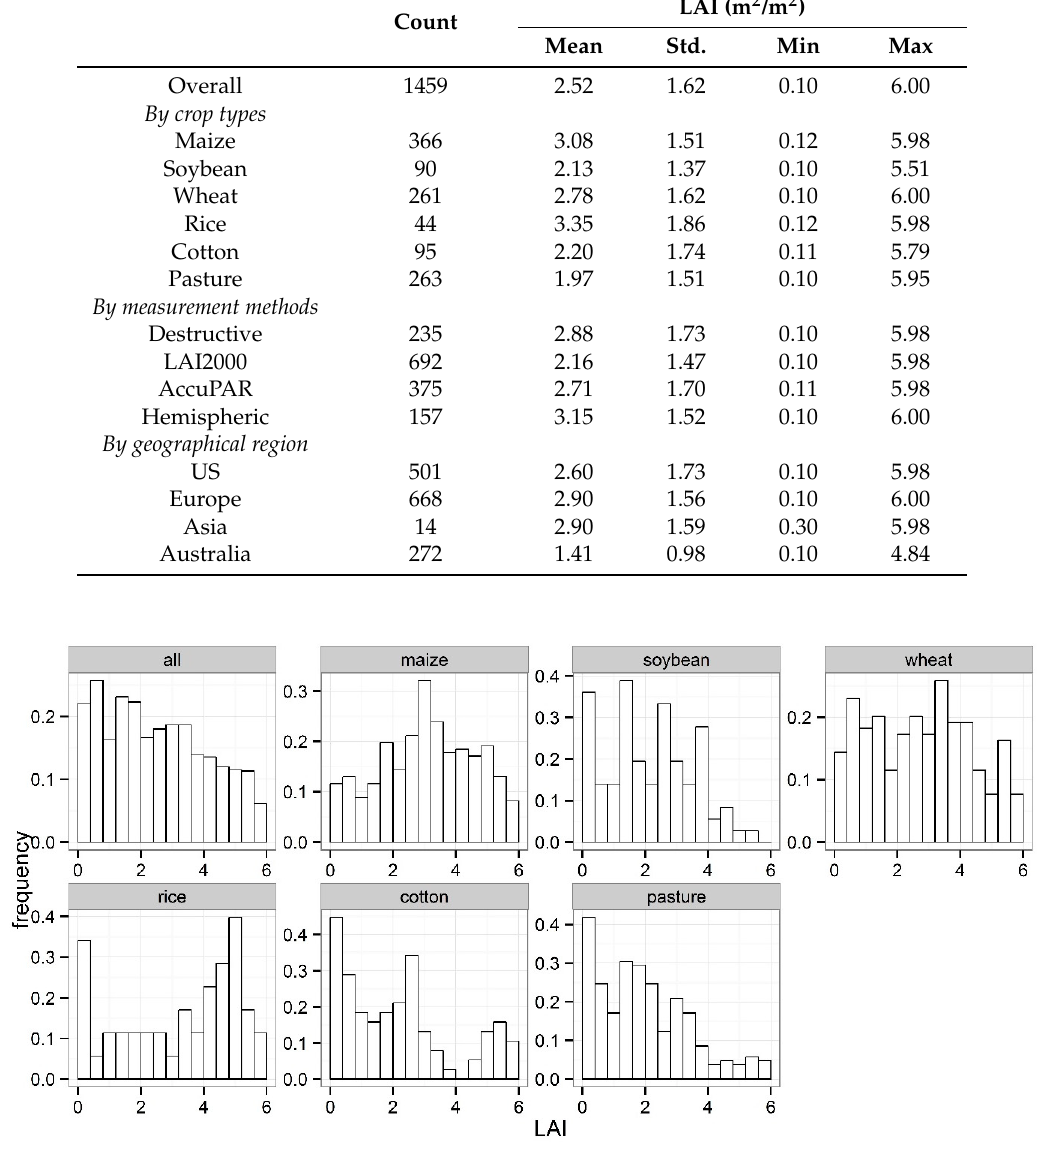
Figure 2. Frequency distribution of the global LAI dataset organised by crop types.